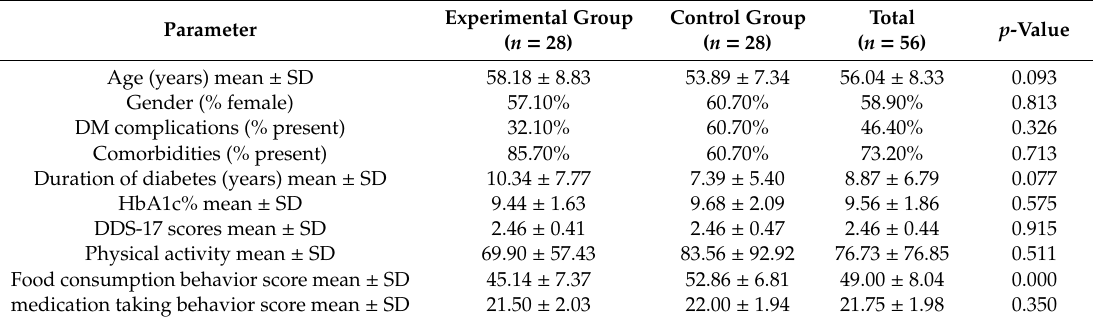
Table 1. Baseline characteristics of